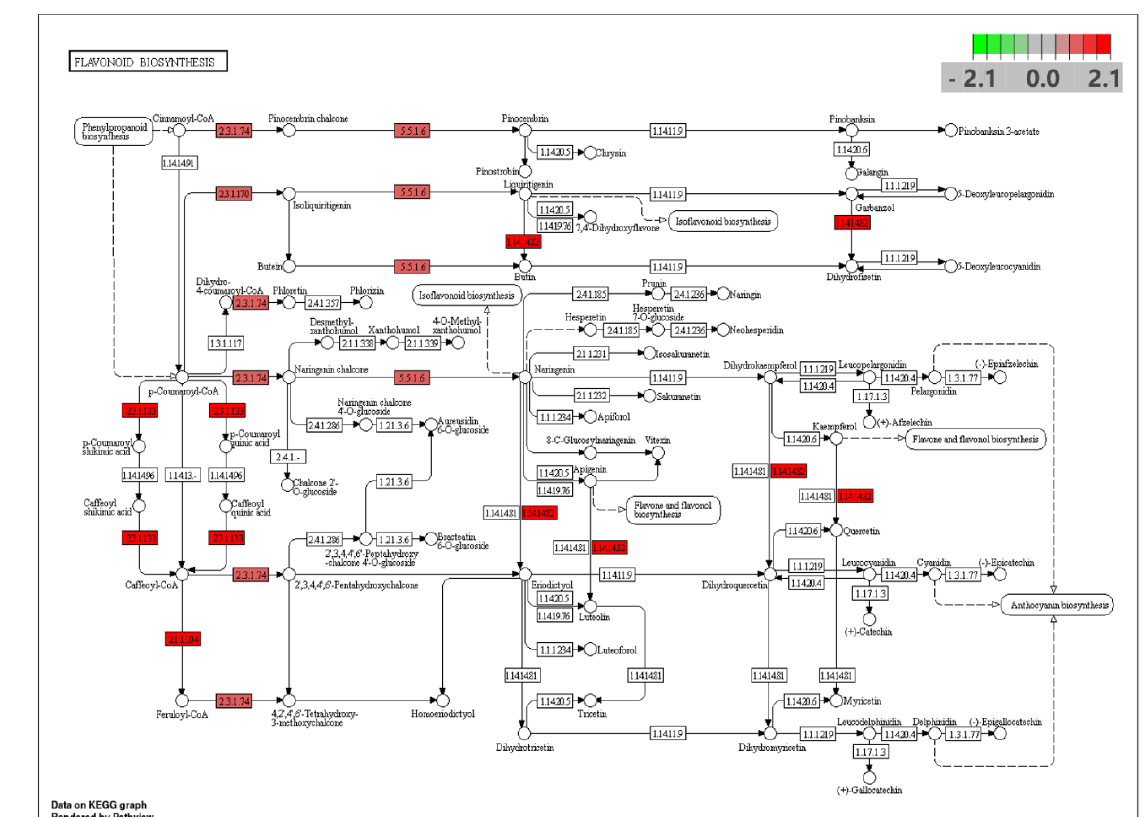
Figure 7. Genes upregulated in the KEGG pathway are designated in red. ( A ) Biosynthetic pathway of phenylalanine. ( B ) Biosynthetic pathway of flavonoid.